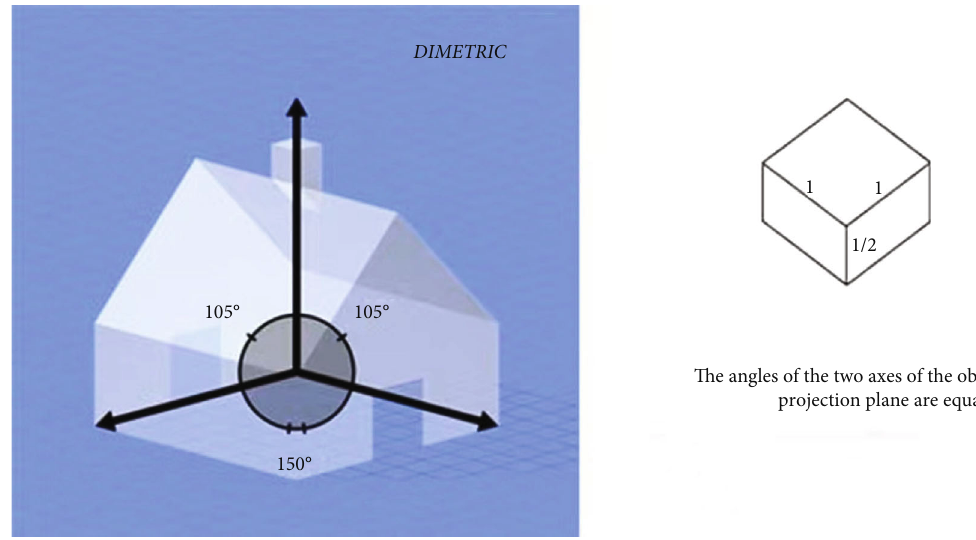
Figure 5: Dimetric projection.